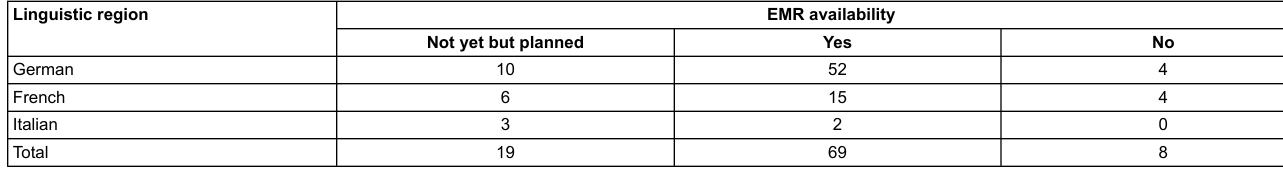
Table S1: EMR status by linguistic region. Linguistic region